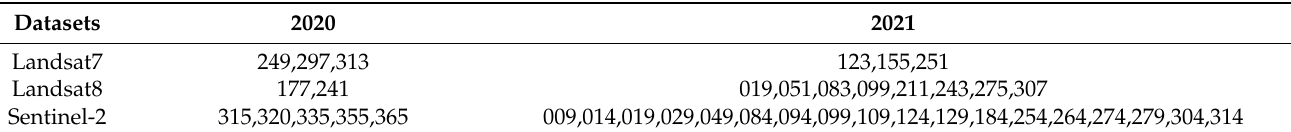
Table 2. Acquisition times of Landsat7 and 8 and Sentinel-2, represented by day of year